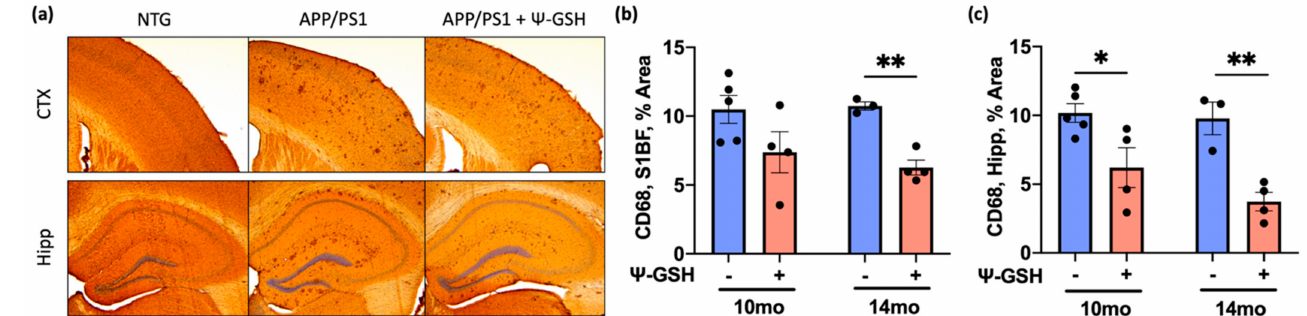
Figure 5. ψ -GSH treatment effectively reduces CD68-positive activated microgliosis in symptomatic 14-mo-old APP/PS1 mice. ( a ) Representative images of CD68 antibody positive microglia in the S1BF region of the cortex and the dorsal hip- pocampus of 14 months-old saline-treated NTG and APP/PS1 mice treated with either saline or ψ -GSH. ( b ) Quantification of CD68-positive immunostained area coverage of the S1BF region of the cortex in 10- and 14-mo-old APP/PS1 mice either treated with saline or ψ -GSH. ( c ) Quantification of CD68-positive immunostained area coverage of the hippocampus in 10- and 14-mo APP/PS1 mice either treated with saline or ψ -GSH. For comparisons between saline and ψ -GSH-treated APP/PS1 groups ( b , c ), an unpaired Student’s t -test was performed for statistical analysis. * p < 0.05, ** p <